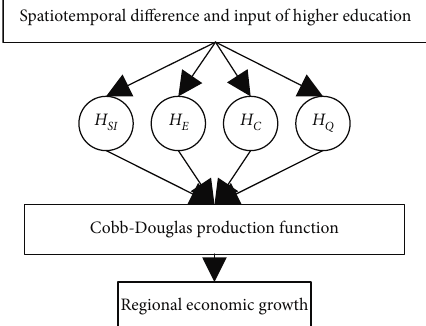
Figure 1: Principle for influence of spatiotemporal difference and input of higher education on regional